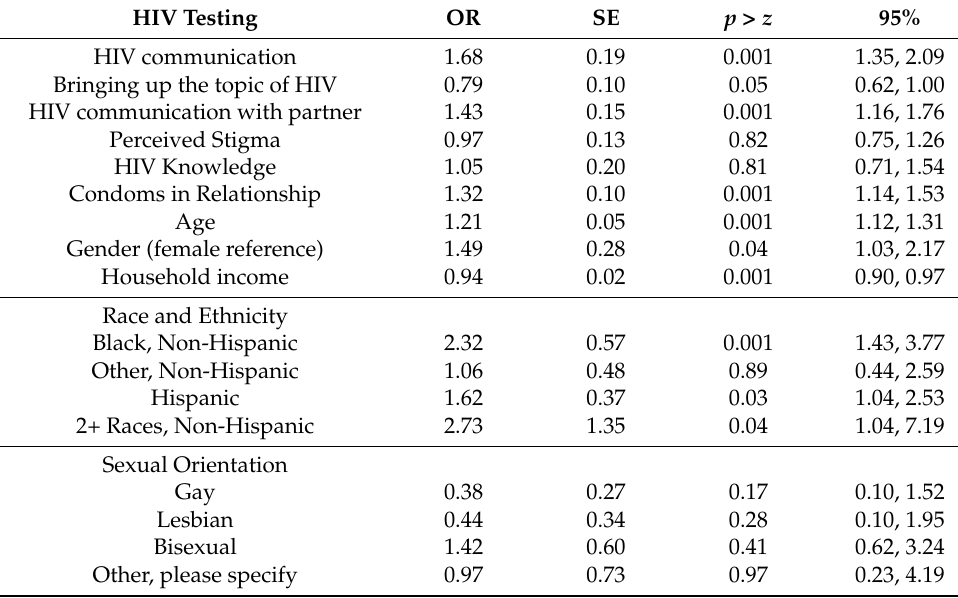
Table 5. Logistic Regression on HIV testing (N =